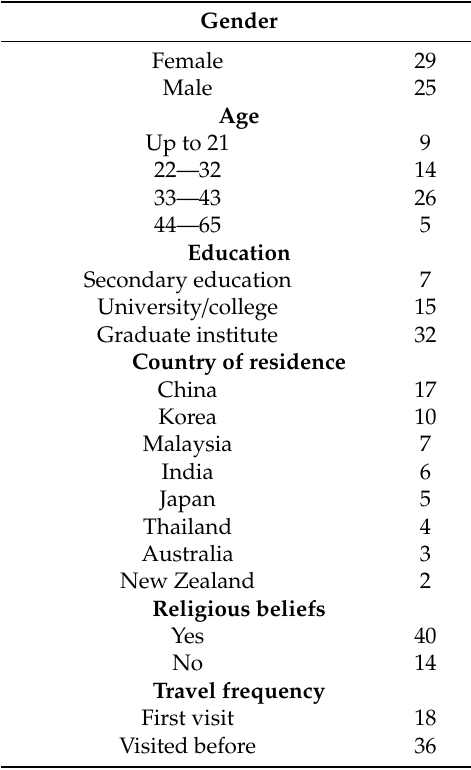
Table 1. Selected respondent characteristics ( N = 54).